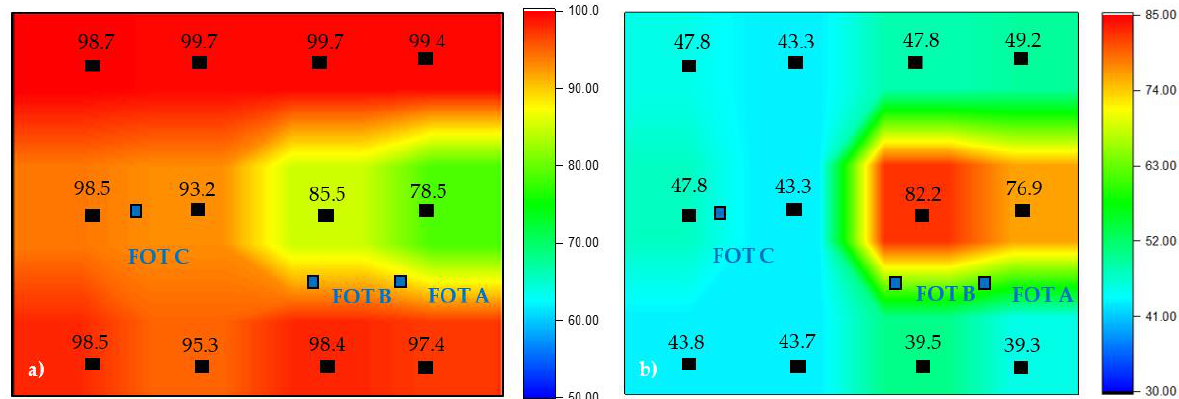
Figure 5. False colour of image of the degree of cure across the microwave cured panel ( a ) without a MAM and ( b ) with MAM-2. The points indicated are the locations where DSC samples were measured and their respective cured percentage values.